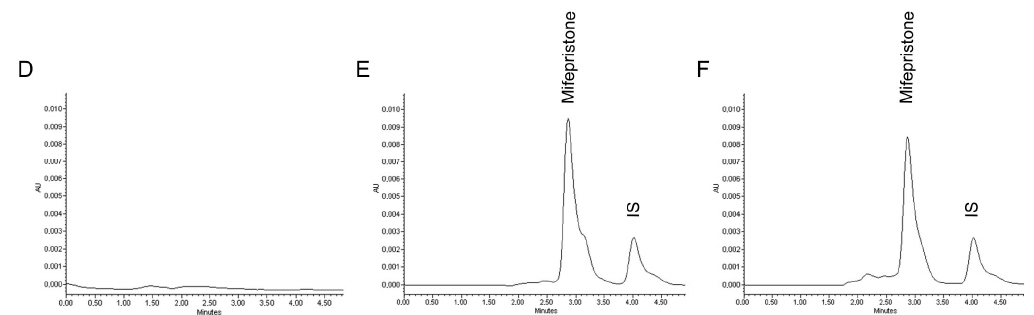
Figure 1. Chromatographic evaluation of the concentration of cisplatin and mifepristone in L-Cis / MF. The images show the peaks for six groups: ( A ) blank liposomes; ( B ) blank liposomes spiked with 10 µ g / mL cisplatin and 25 µ g / mL NiCl 2 , the internal standard (IS); ( C ) cisplatin drawn from an L-Cis / MF sample and spiked with its IS; ( D ) blank liposomes; ( E ) blank liposomes spiked with 4 µ g / mL mifepristone and 4 µ g / mL of promegestone (IS); ( F ) mifepristone drawn from a L-Cis / MF sample and Pharmaceutics 2020 , 12 , x FOR PEER REVIEW spiked with its IS.